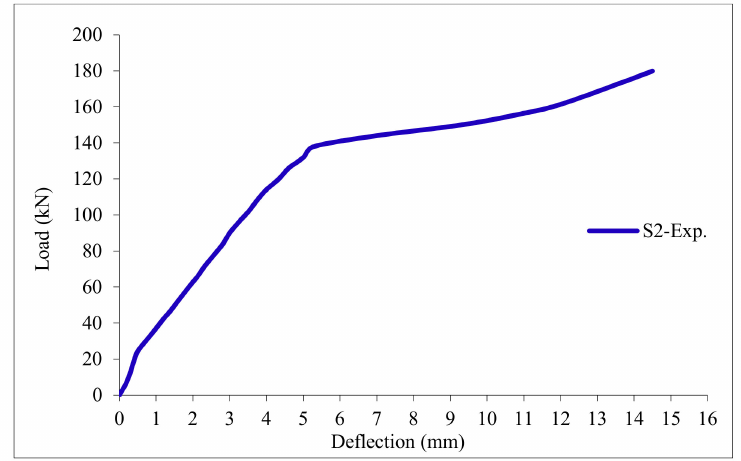
Figure 18. Load deflection curve for slab S2.